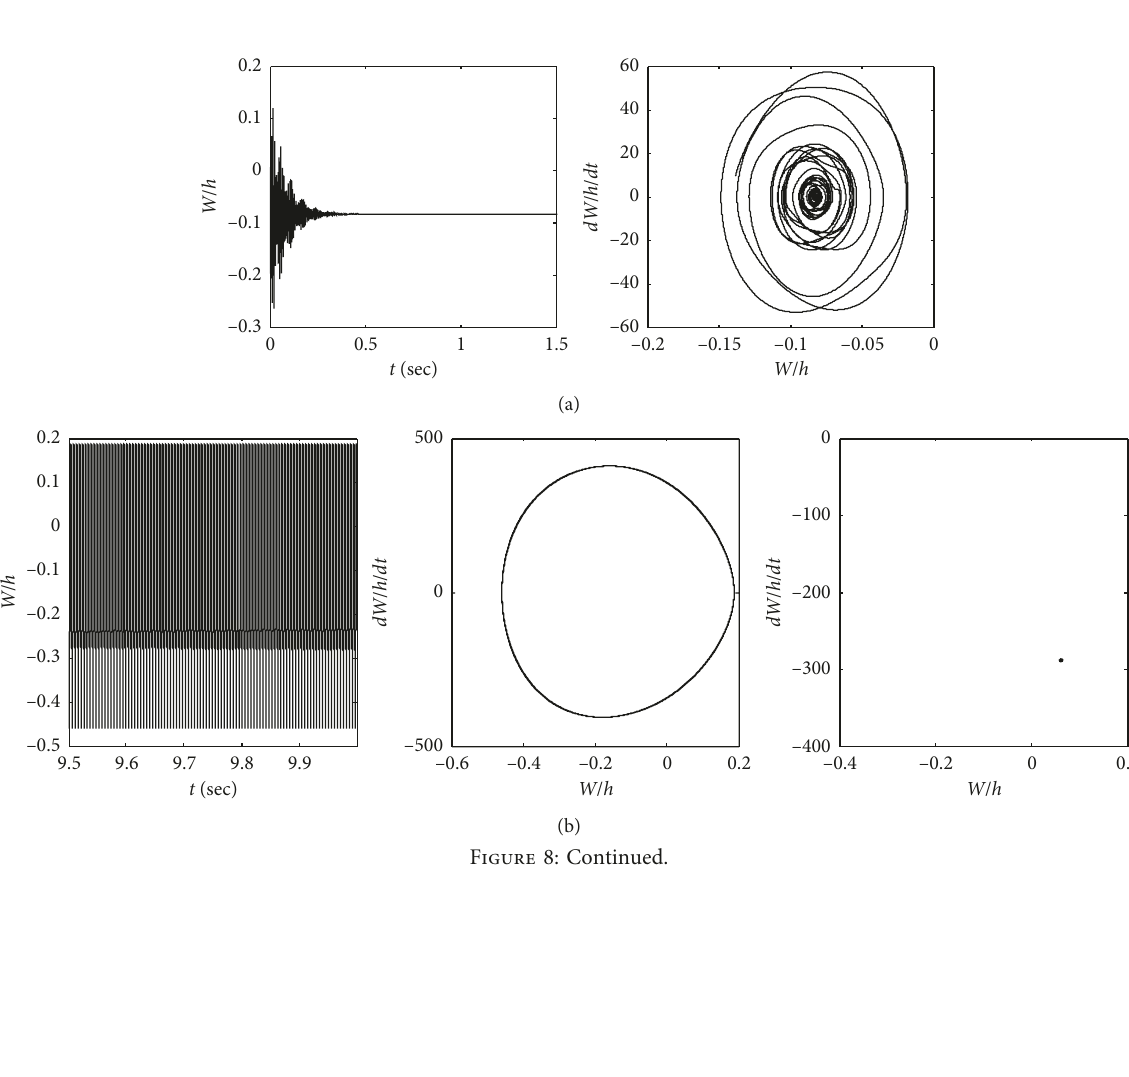
� 1 , and V � V � 1000 U L cr